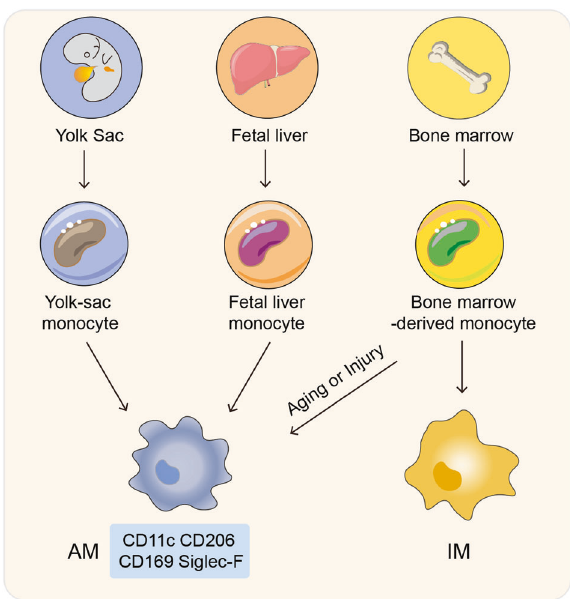
Fig. 3 The origin of lung macrophages in mice. Lung macrophages mainly include two populations, AMs and interstitial macrophages (IMs). IMs originate from bone marrow-derived monocytes and are maintained by circulating monocytes. Unlike IMs, AMs are estab- lished prior to birth in the yolk sac, where erythromyeloid progenitors (EMP) develop at embryonic day (E) 8.5. Subsequently, progenitors migrate to the fetal liver, generating monocyte clones at E12.5. After birth, bone marrow-derived monocytes can be recruited to alveoli in aging mice or injured mice, as a supplement for AMs. In fact, in the steady-state, AMs maintain themselves by self-renewal. Murine AMs highly express CD11c, CD206, CD169, and Siglec-F